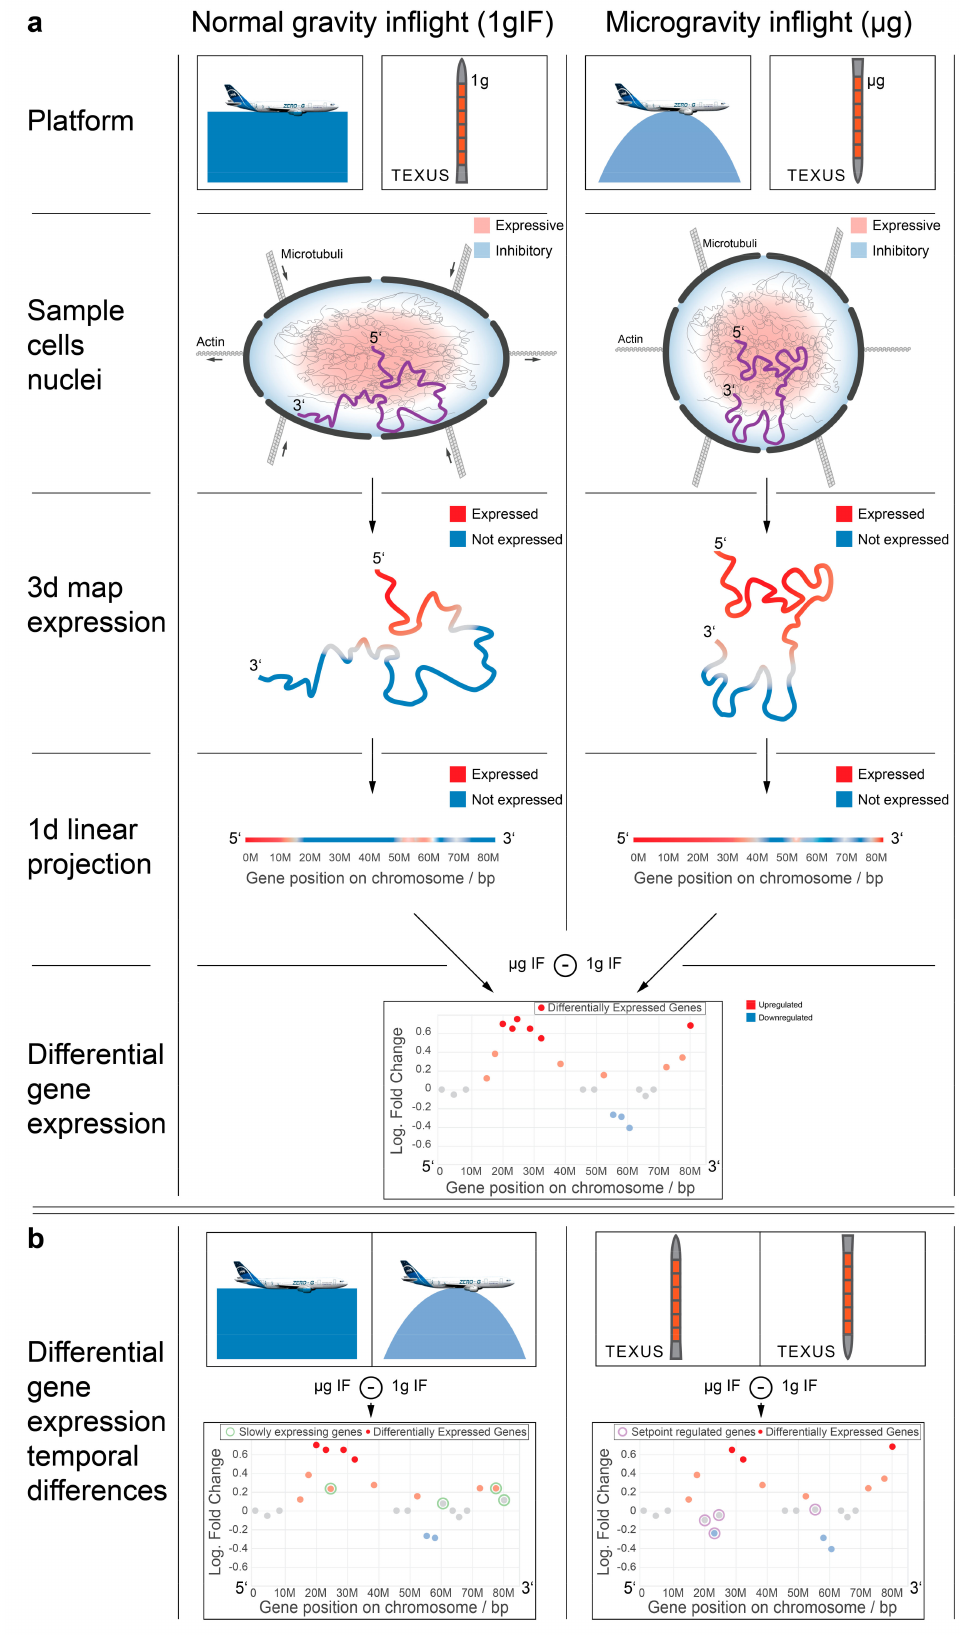
Figure 9. Summary of the proposed hypothesis. ( a ) effects of altered gravity on cellular gene The expression are proposed to have a mechanical nature. Cells on different platforms are exposed to